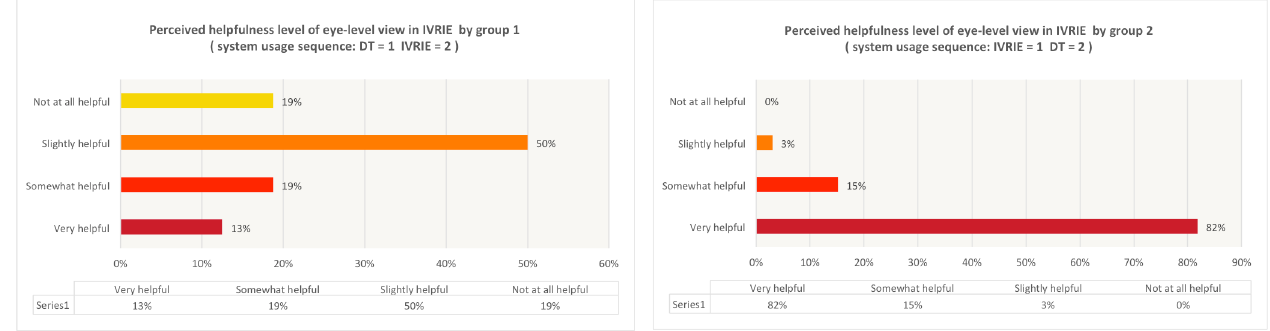
Figure 10. Evaluations of using the eye-level view by groups with opposite system usage sequences.